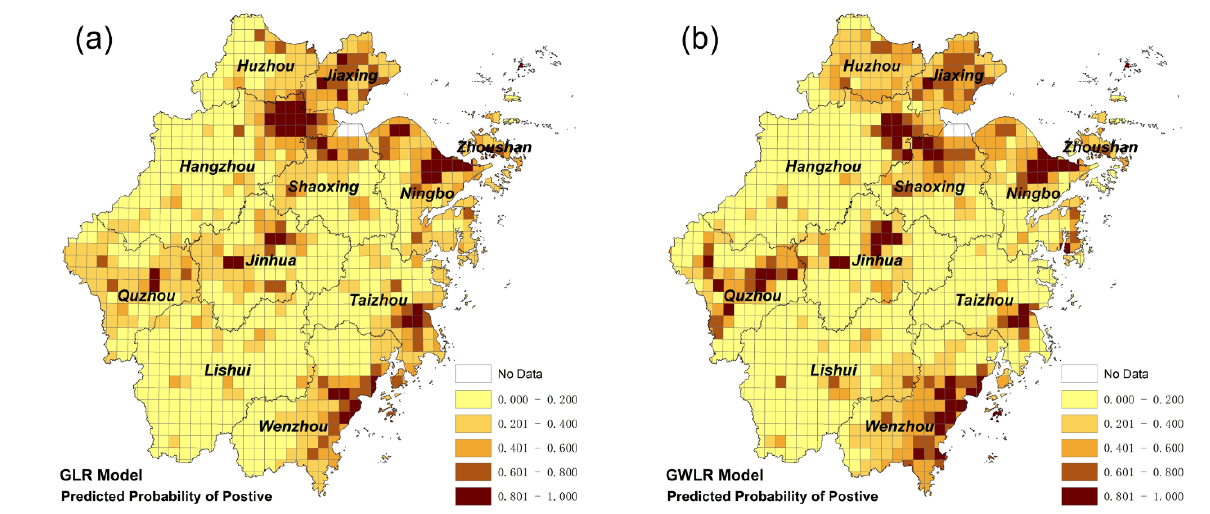
Figure 5. Predicted risk map of foodborne disease cases caused by V. parahaemolyticus . ( a ) Global logistic regression model; ( b ) geographically weighted logistic regression model. Table 5. Percentage of foodborne disease risk areas and average prediction probability based on geographically weighted logistic regression model.